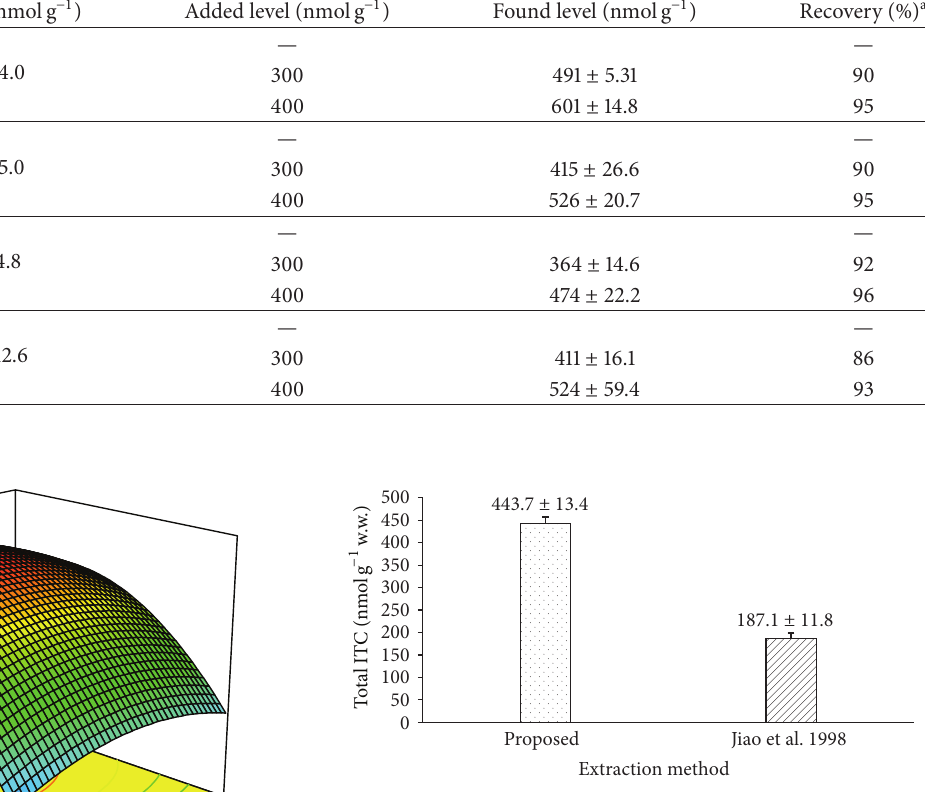
Figure 4: Comparison of different extraction techniques (proposed and reported by Jiao et al.